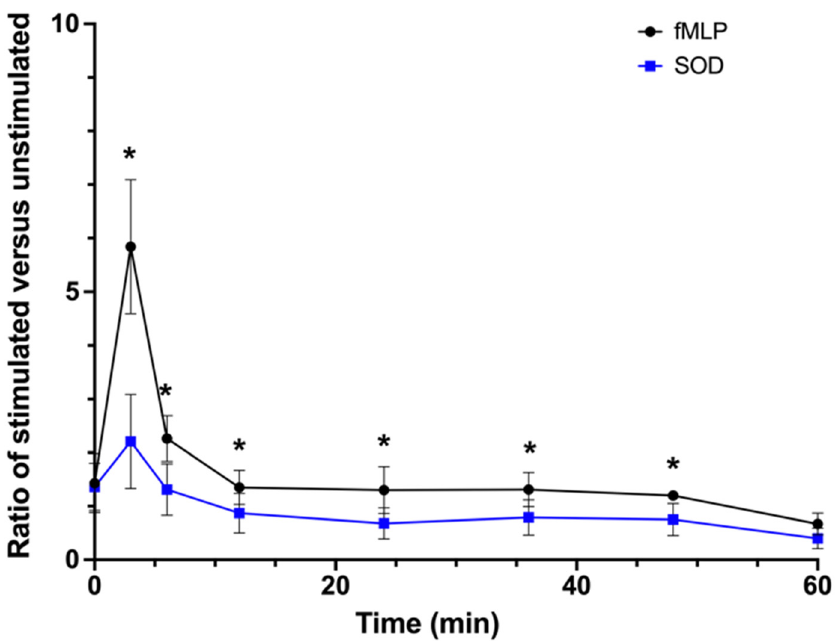
Figure 4. Changes in chemiluminescence of fMLP-stimulated mixed tear PMNs with and without the addition of superoxide dismutase (SOD). Results are reported as ratio of fMLP-stimulated PMNs (with and without SOD) CL emissions over control (unstimulated PMNs) CL emissions. Values